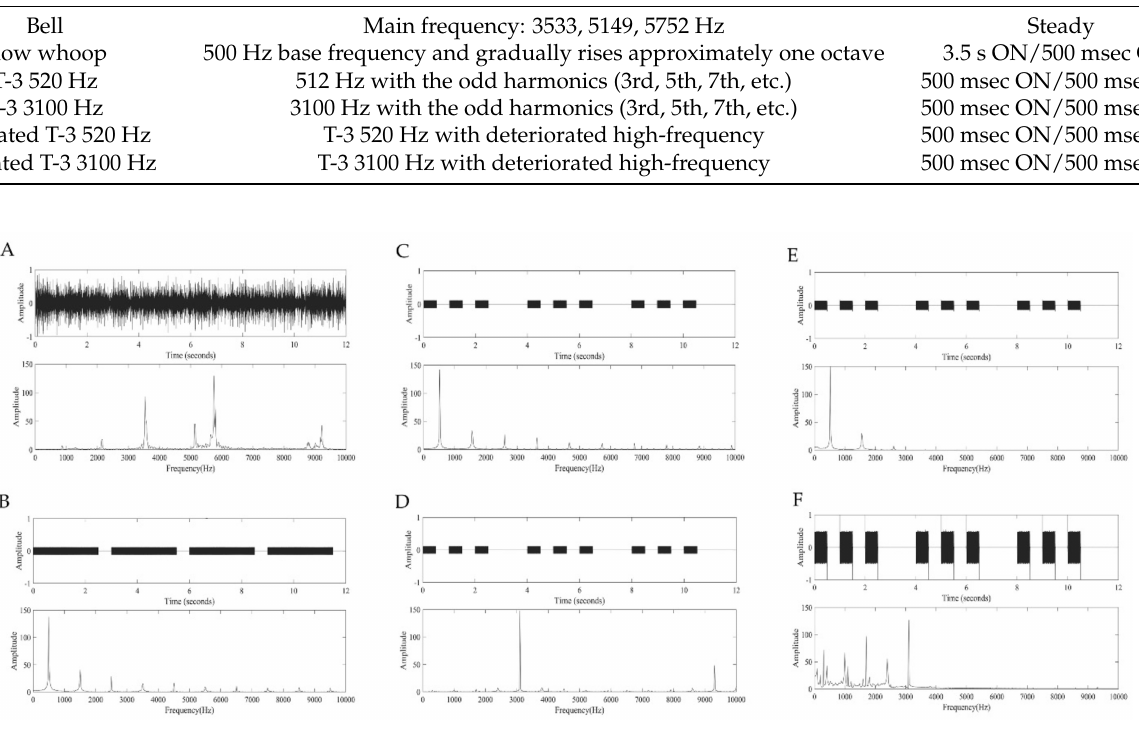
Figure 2. A screenshot of spectrum analysis for the six fire alarm sounds applied in the present study: bell ( A ), slow whoop ( B ), T-3 520 Hz ( C ), T-3 3100 Hz ( D ), simulated T-3 520 Hz ( E ), simulated T-3 3100 Hz ( F ). Each panel had an amplitude of two aspects for the time domain (upper) and frequency domain